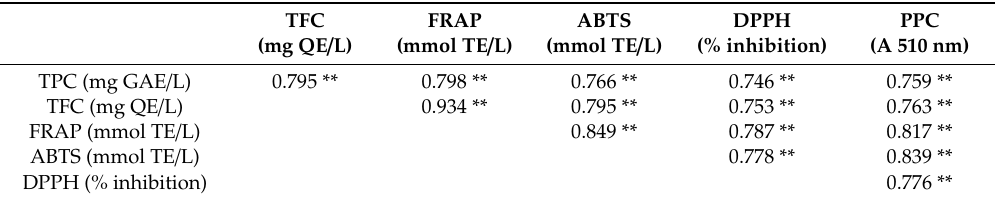
Table 9. Pearson correlation coe ffi cients for the interaction between TPC, TFC, PPC and the antioxidant capacity of the cider variants (expressed by ABTS, FRAP values and DPPH % inhibition values).